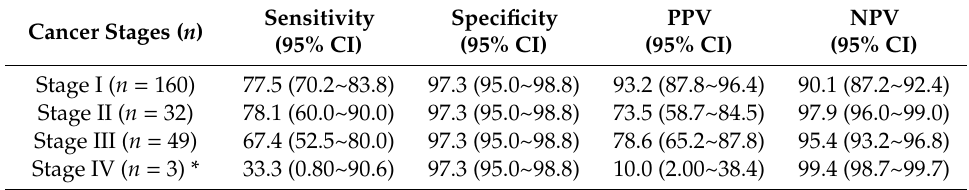
Table 5. The e ffi ciency of the LC index for the detection of stage I~stage IV lung cancer patients.